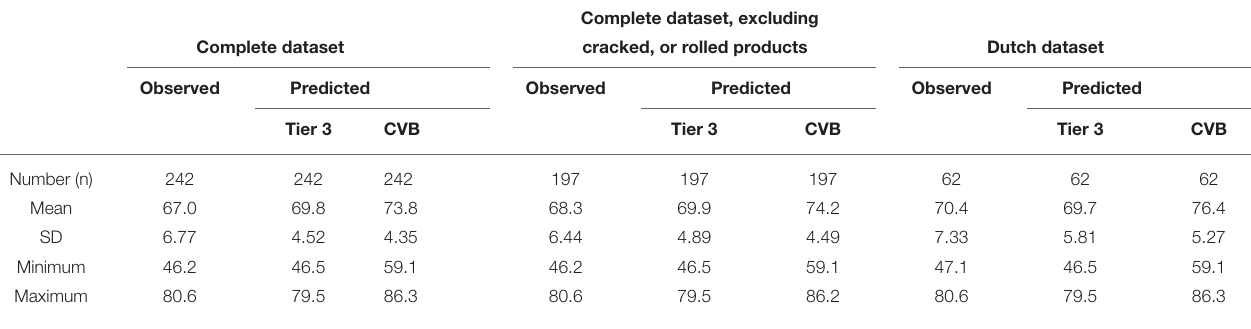
TABLE 4 | Summary of observed and predicted apparent fecal N digestibility (as % of N intake) for the complete dataset, the complete dataset excluding rolled or cracked high moisture maize silage, and the Dutch